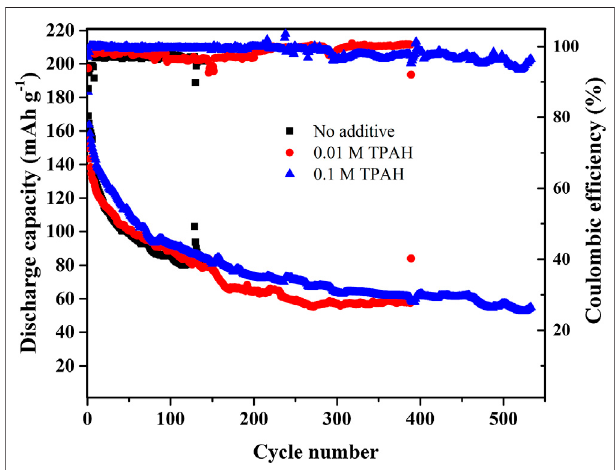
FIGURE 8 | The cyclability of Zn//ZnCl 2 + LiCl//LiFePO 4 batteries with and without TPAH additive in electrolyte at 0.5 C.